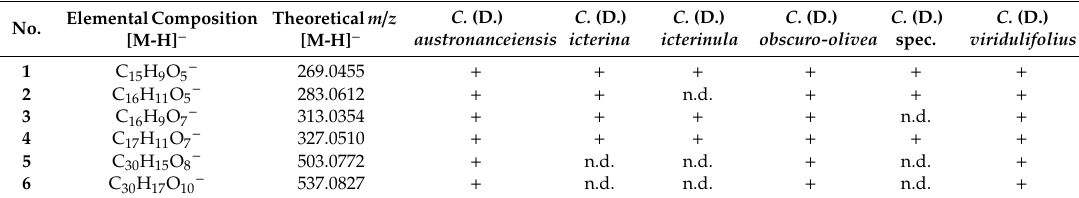
Table 1. Detected anthraquinones ( 1 – 6 ) using HPTLC-desorption electrospray ionization (DESI)-high-resolution mass spectroscopy (HRMS).